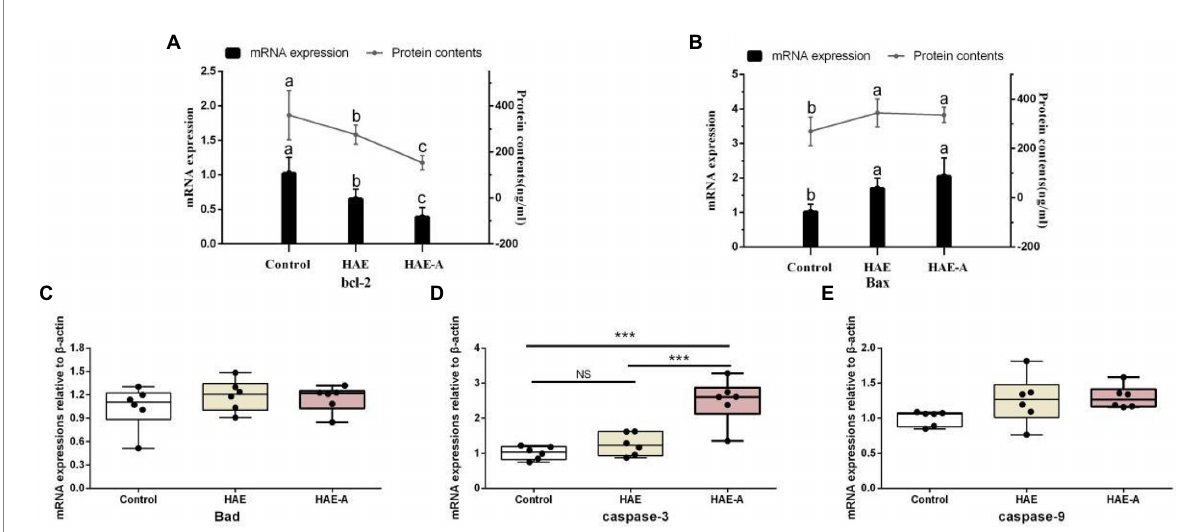
FIGURE 5 Apoptosis-related functional protein contents and mRNA expression levels in the prefrontal cortex. Data are presented with the means ± standard deviation ( n = 6). Bars with different letters are significantly different on the basis of Duncan’s multiple-range test ( p < 0.05). NS, not significant ( p > 0.05); *difference is significant at the 0.05 level ( p < 0.05); **difference is significant at the 0.01 level ( p < 0.01); ***difference is significant at the 0.001 level ( p < 0.001). (A,B) : mRNA expression levels and protein contents of bcl-2 and Bax; (C–E) : mRNA expression levels of Bad, caspase-9 and caspase-3, respectively.